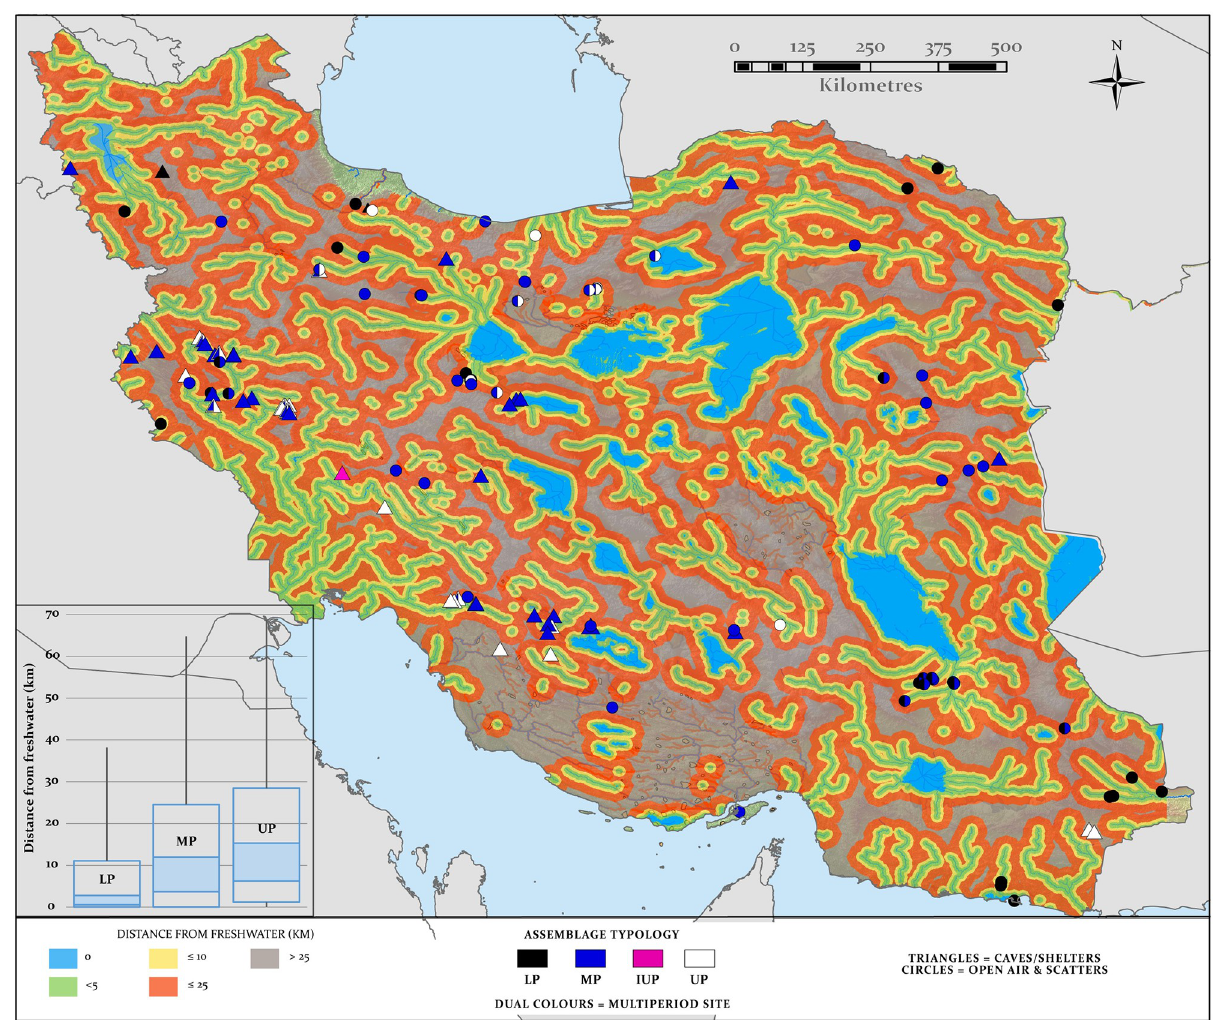
Fig 8. Distance from water analyses highlighting the distance from mapped paleohydrology for all areas of the country. The inset graph shows box plots of the distance from water of LP, MP and UP sites. Map created by one of our authors (PSB).